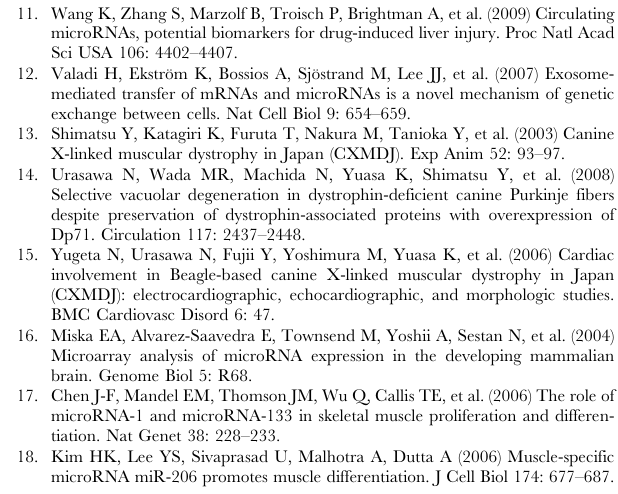
Figure S2 (a) Confirmation of the consistency of miRNA isolation from serum. C. elegans miR-39 (cel-miR-39) was chemically synthesized and added to the denatured mouse serum samples. Total RNA was isolated from the mouse serum samples,